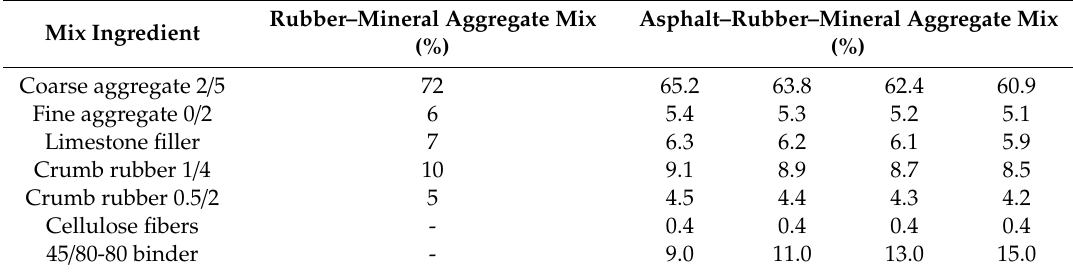
Table 2. SEPOR-PSMA5 W4 poroelastic mixture composition.